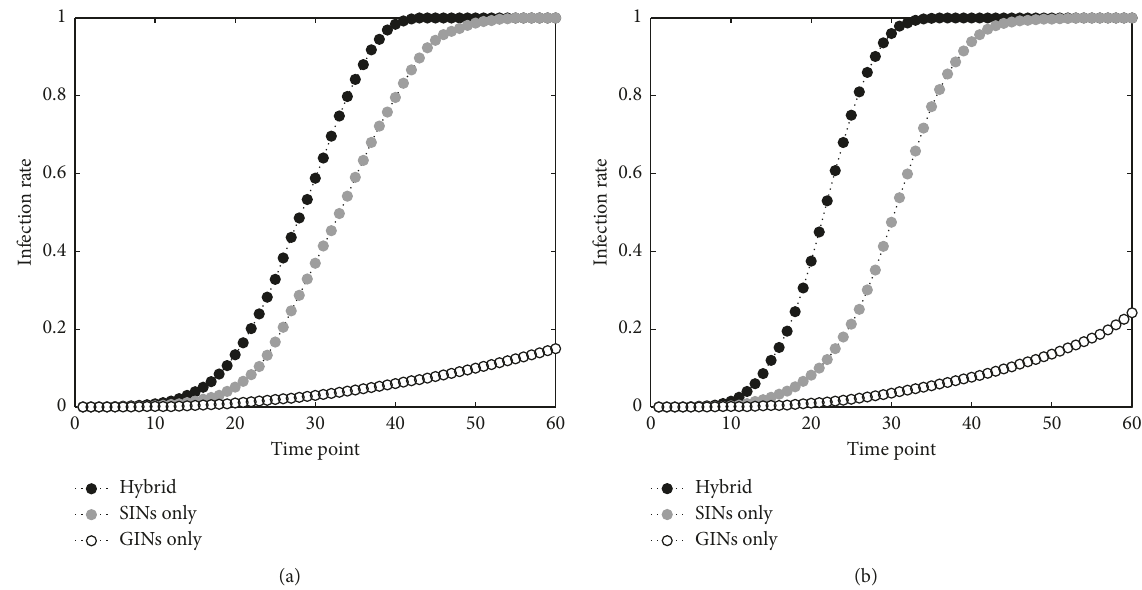
Figure 3: Propagation performance of the worm spreading via the SINs, the GINs, and the hybrid mode: (a) GINs � 0.75 and η 6 and (b) GINs � 0.85 and _ η